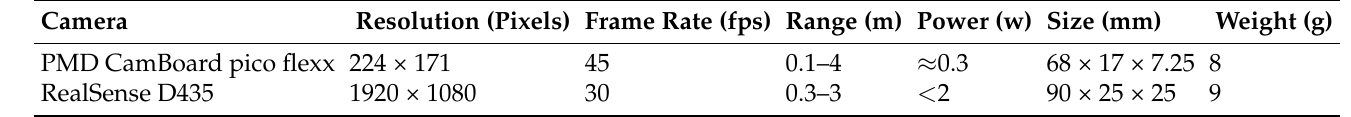
Table 2. Specifications of the chosen pico flexx [69] and RealSense D435 cameras [70].